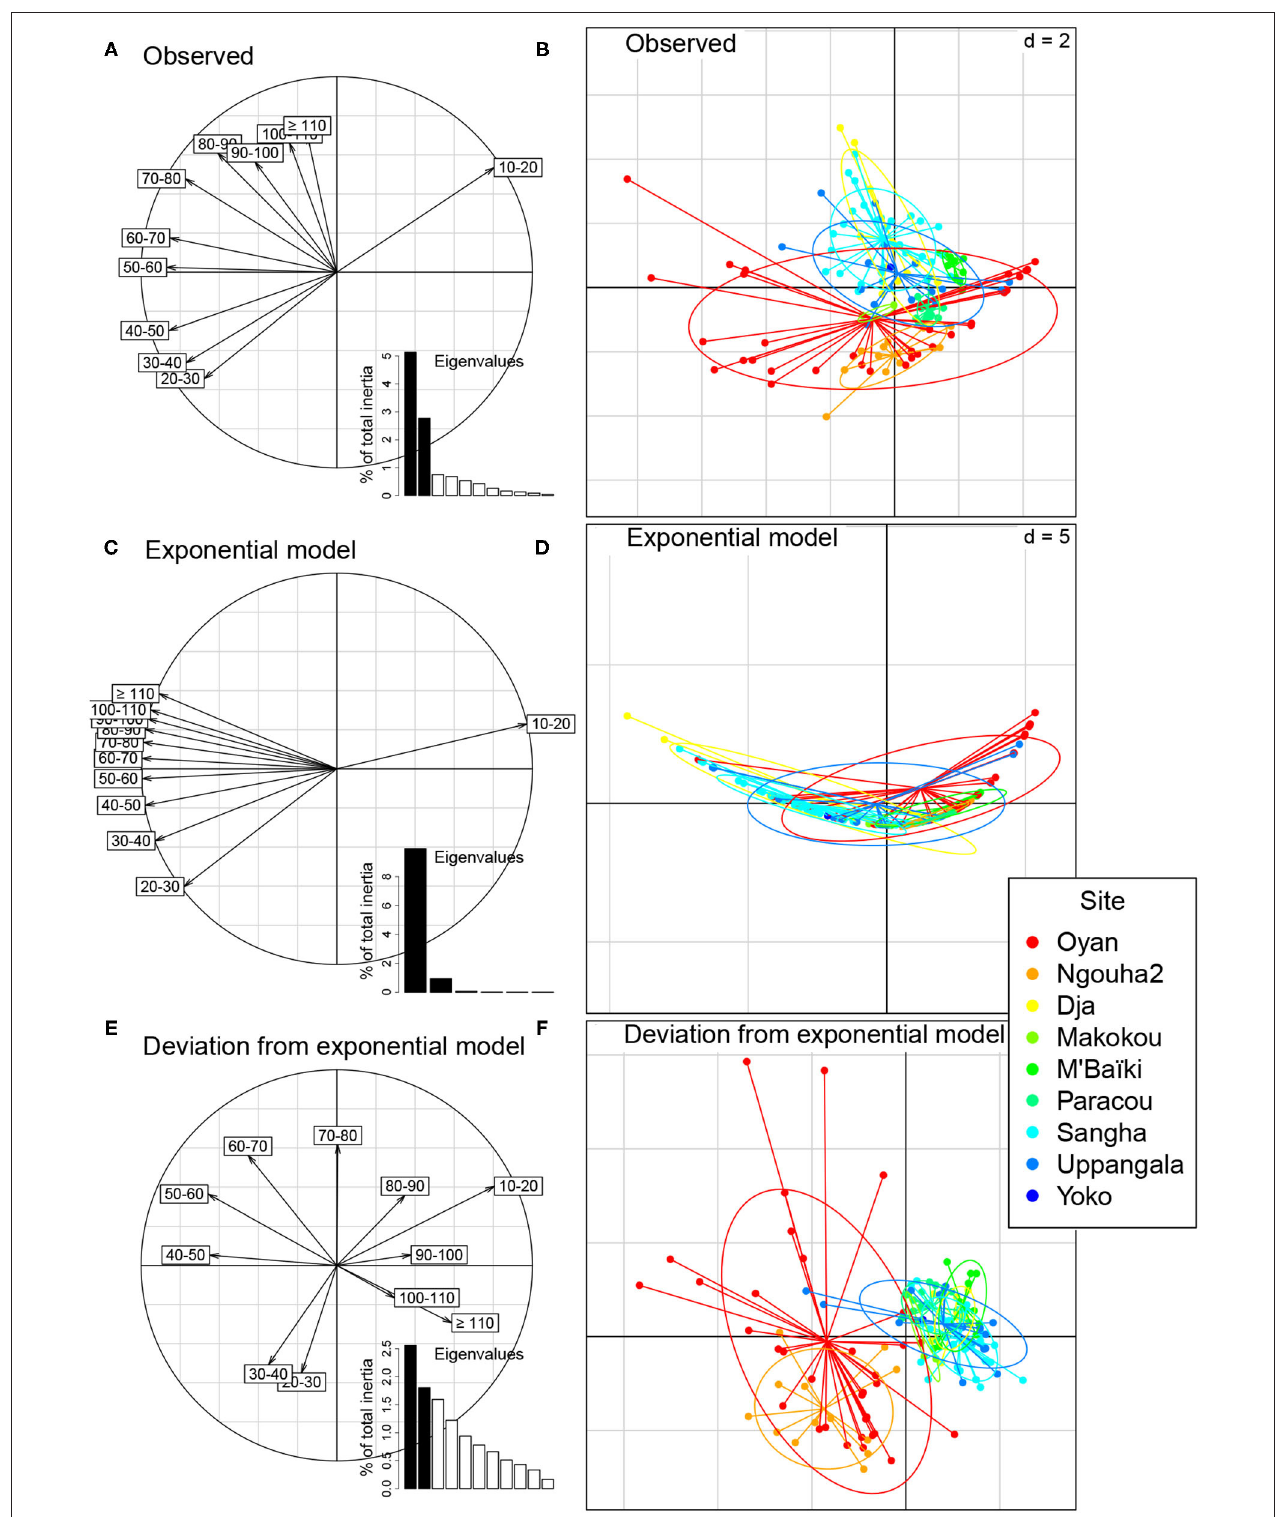
FIGURE 5 | Principal component analysis (PCA) of the chord-transformed abundances of stems per dbh class in 133 forest plots at nine sites. The PCA is performed either on the matrix of observed abundances (A,B) , on the modeled abundances using the exponential model (C,D) , or on the deviations of observations to